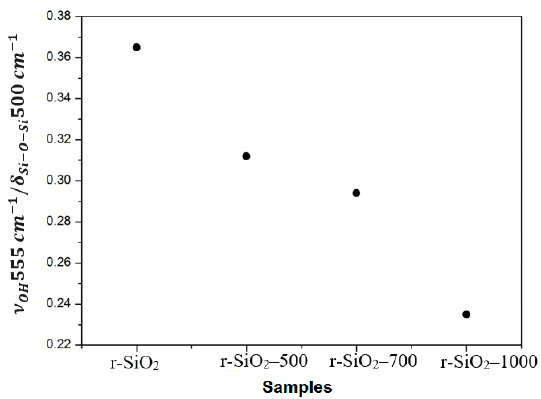
Figure 8. The evolution of the intensity ratio between the Si-OH band located around 555 cm − 1 and the structural band located around 500 cm − 1 .